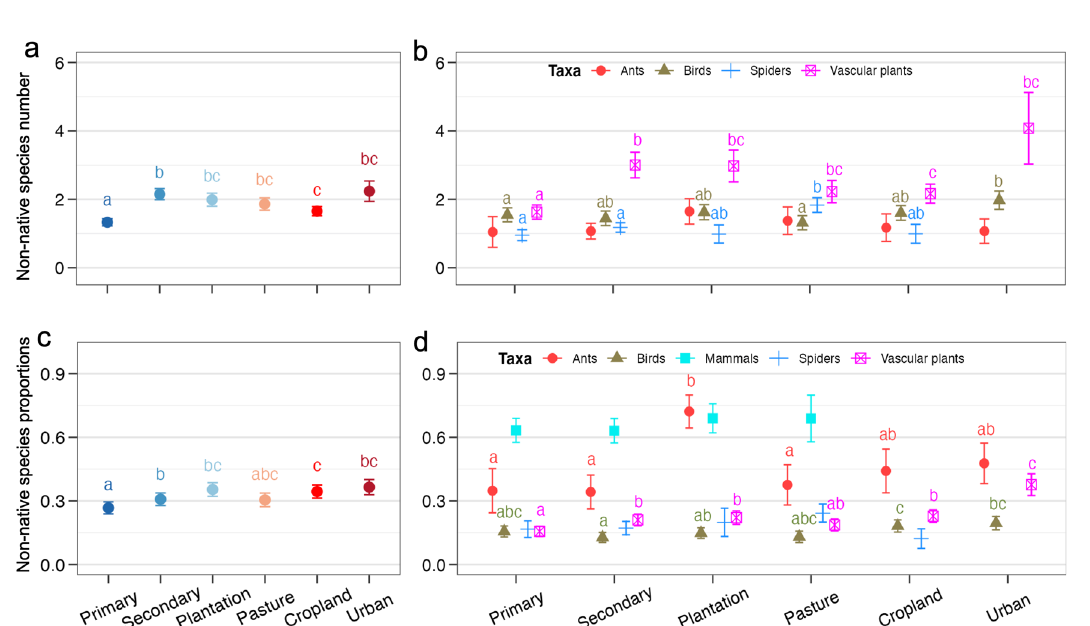
Fig. 4 | Numbers and proportions of non-native species among all species in localassemblagescontainingatleastonenon-nativespeciesindependenceon LU-type. Panels a and c present models fi t across all fi ve focal taxonomic groups (across all taxa) ( n =2450). Panels b and d models fi tted for each taxon separately ( n =113, 457, 292, 182 and 1406; respectively). The statistical model test used are two-sided. The different letters indicate signi fi cant differences ( p <0.05) for all pairwise comparisons among LU-types. If there were no signi fi cant differences